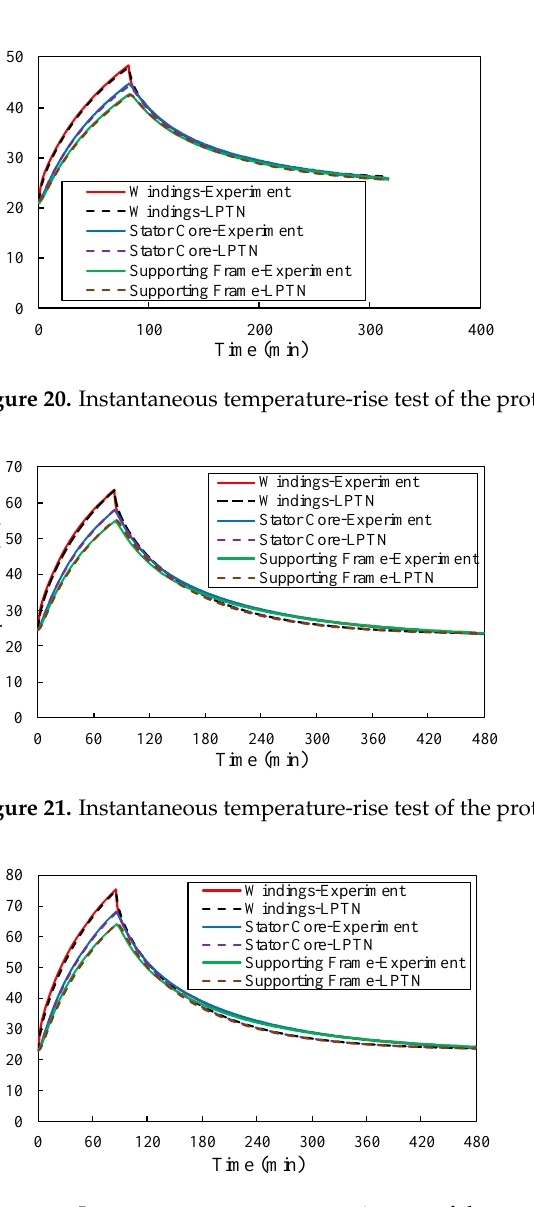
Figure 22. Instantaneous temperature-rise test of the prototype under 13.5 A DC.